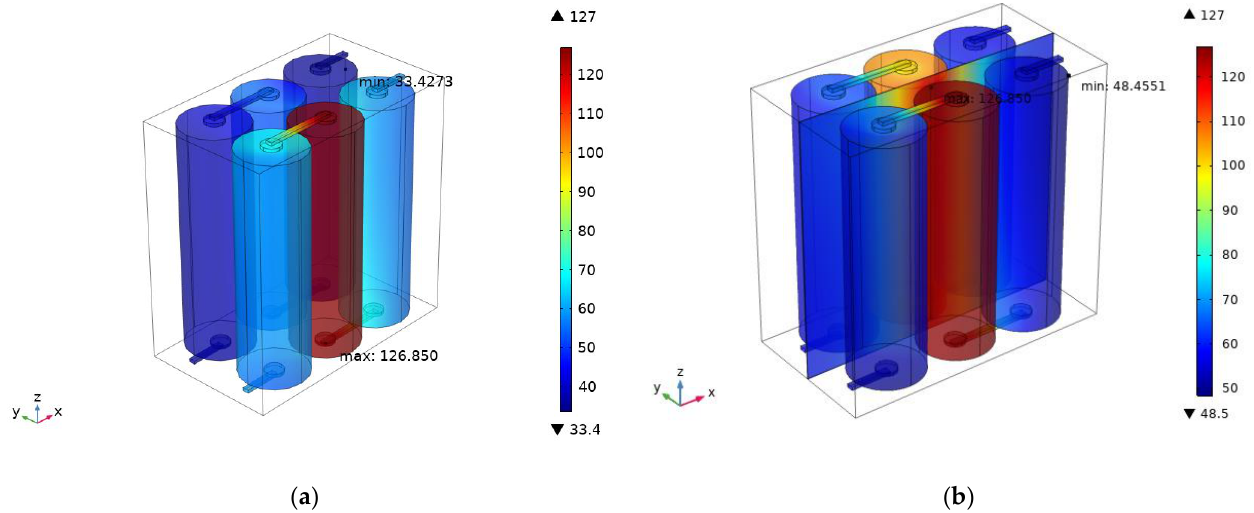
Figure 12. Temperature distribution inside the battery pack after 1500 s: ( a ) no thermal conductive layer; ( b ) by considering the GNP layer as heat spreader with the ambient.